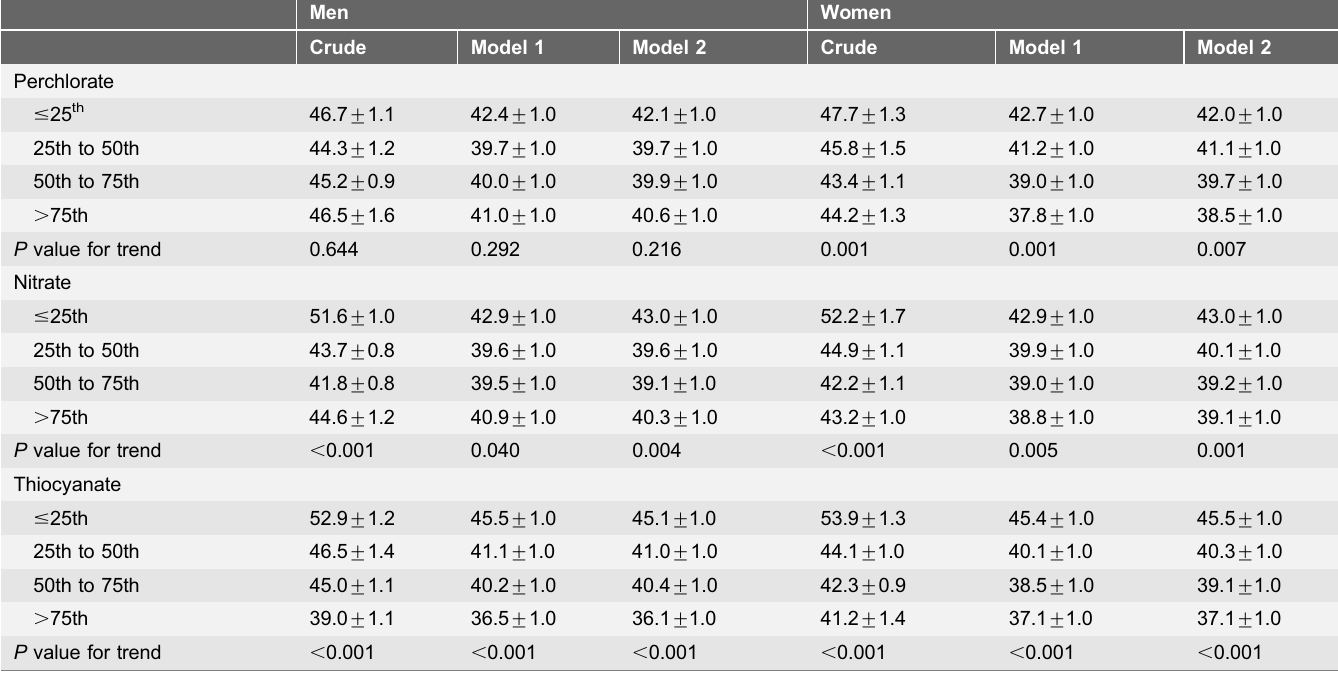
Table 3. Weighted mean ¡ SE of serum parathyroid hormone levels (pg/mL) across quartiles of creatinine-corrected urinary concentrations of perchlorate, nitrate, and thiocyanate among the United States adults, NHANES